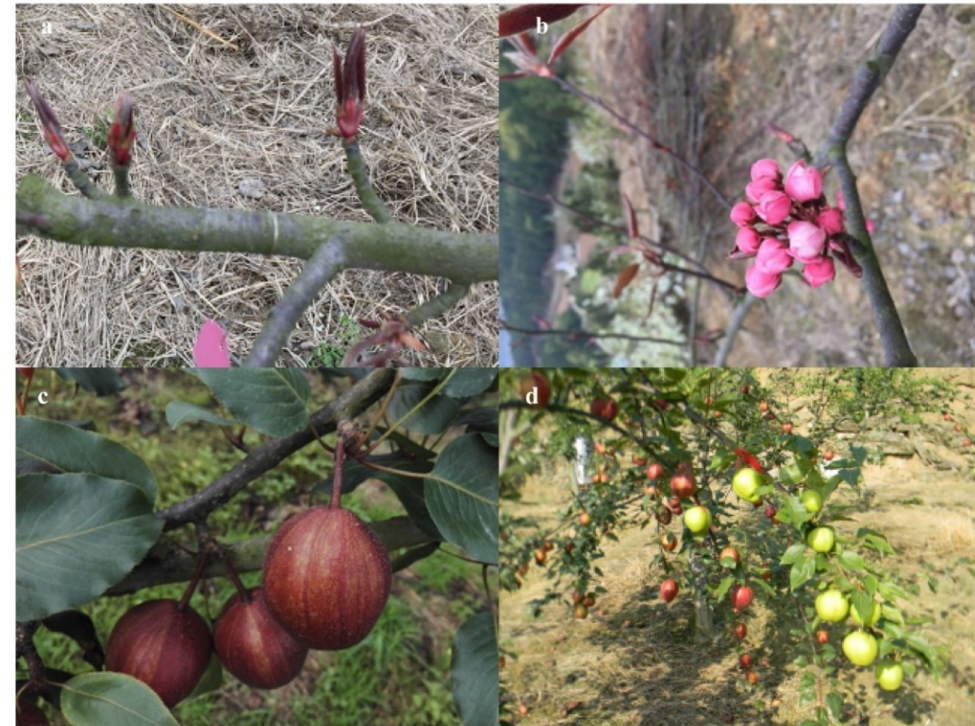
Figure 2. Different tissues and organs of ‘Red Zaosu’. ( a ) New shoots; ( b ) flowers; ( c ) mature fruits; ( d ) pear tree ‘Red Zaosu’ bearing red fruits and green mutants within a single